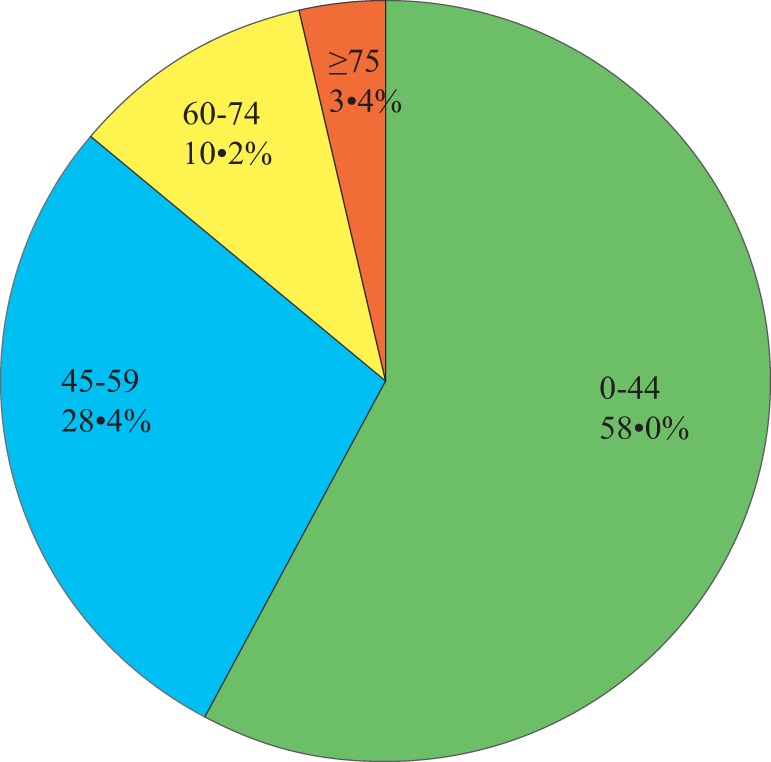
Pie chart of the 88 patients' age.